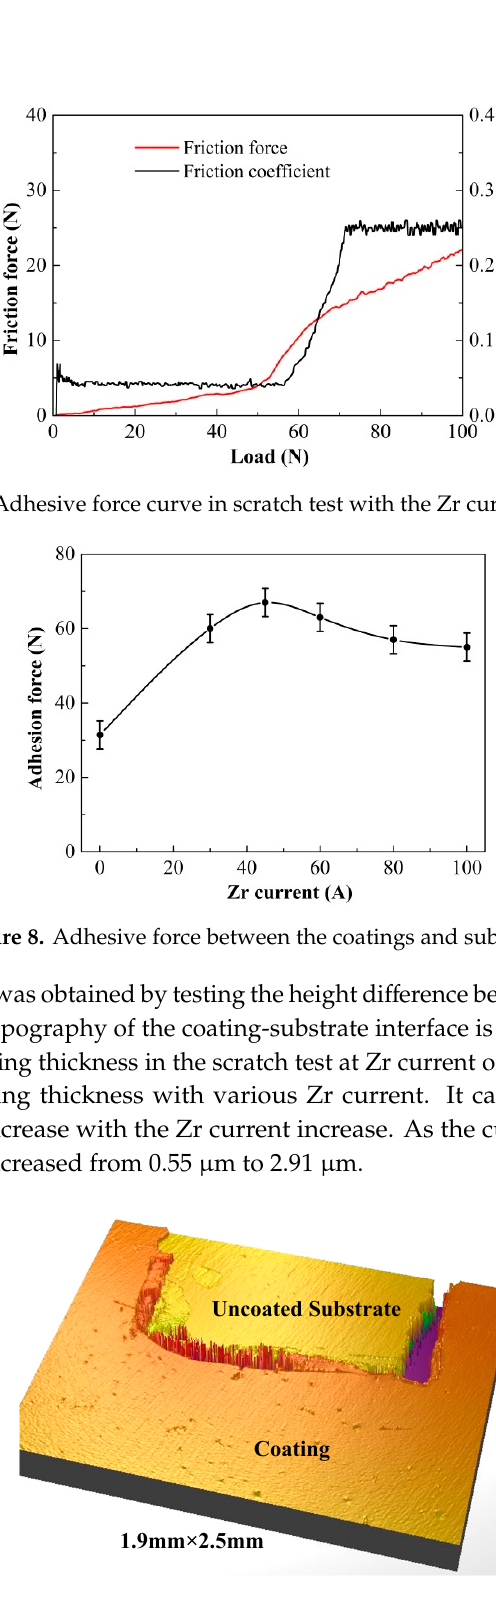
Figure 9. The surface topography of the coating-substrate interface.